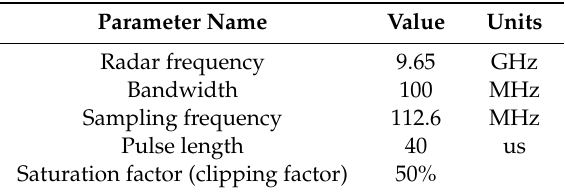
Table 1. One-dimensional simulation parameters.